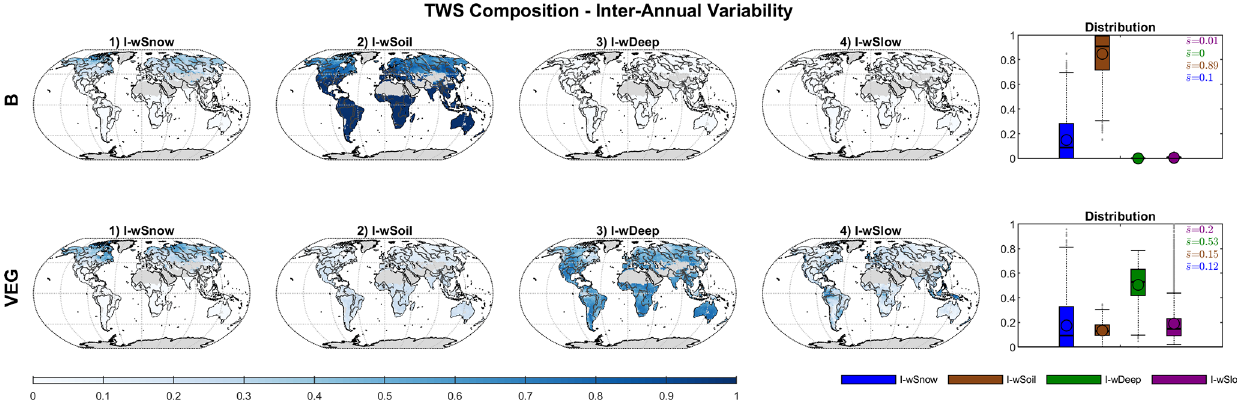
Figure 7. Global distribution of the impact index I for the contribution of simulated snow (wSnow), soil (wSoil), deep water storage (wDeep), and delayed water storage (wSlow) to the inter-annual variability of total water storage, for B and VEG.